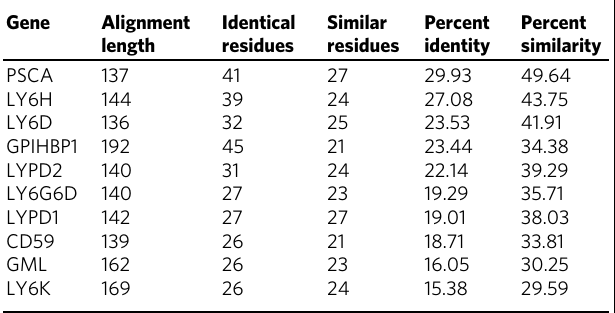
Table 1 LY6/uPAR family protein